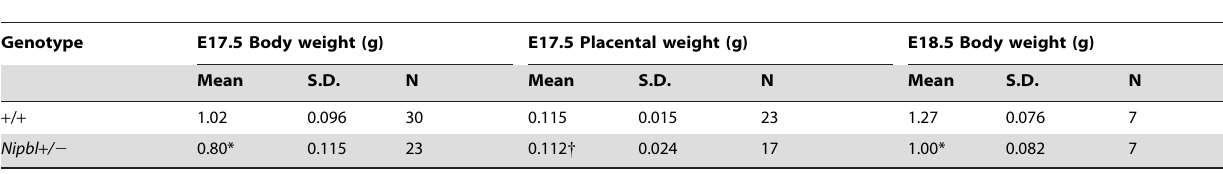
Table 2. Prenatal growth retardation in Nipbl + / 2 embryos.